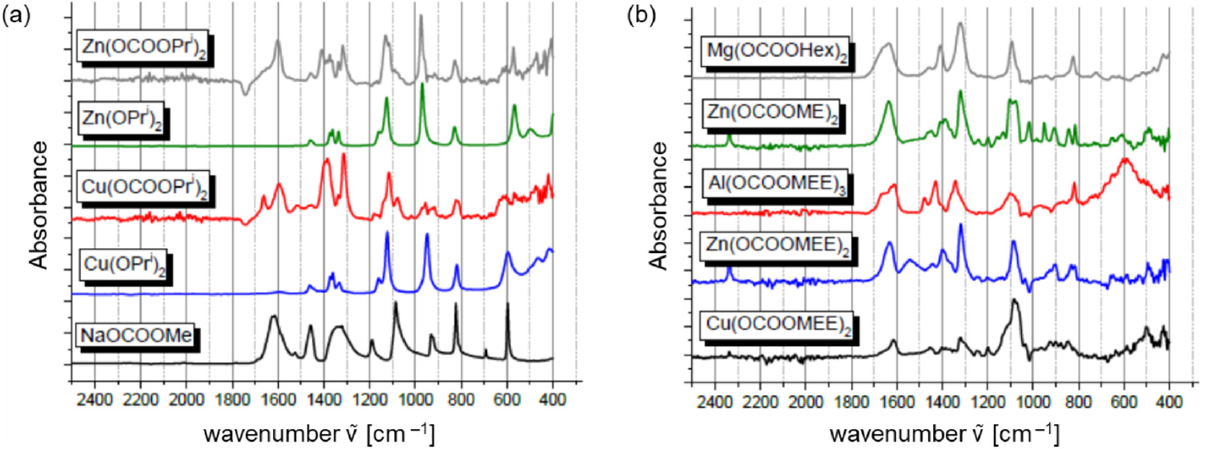
Figure 3. ( a ) ATR-IR absorption spectra of Zn(O(O)CO i Pr) 2 , Zn(O i Pr) 2 , Cu(O(O)CO i Pr) 2 , Cu(O i Pr) 2 and Na(O(O)COMe). ( b ) ATR-IR absorption spectra of Mg(O(O)COHex) 2 , Zn(O(O)COME) 2 , Al(O(O)COMEE) 3, Zn(O(O)COMEE) 2 and Cu(O(O)COMEE) 2 between 2500–400 cm − 1 (OMEE = 2(2-methoxyethoxy)ethanol, OME = 2-methoxyethanol). In order to confirm the IR results further, NMR spectroscopic studies of Mg[Al(O i Pr) 4 ] 2 before and after the insertion of 13 C-enriched CO 2 were carried out in d 6 -DMSO (Figure 4). After the insertion, two new peaks at 156.6 and 159.0 ppm become obvious in the 13 C NMR spectrum, as well as a peak for free CO 2 , which verifies the formation of alkyl carbonate groups (O-CO 2 ) and, therefore, metal alkyl carbonates [46]. The broadening and splitting of the peaks are interpreted to be due to the non-equivalent chemical environments of the O-CO 2 group within a heterometallic alkyl carbonate.